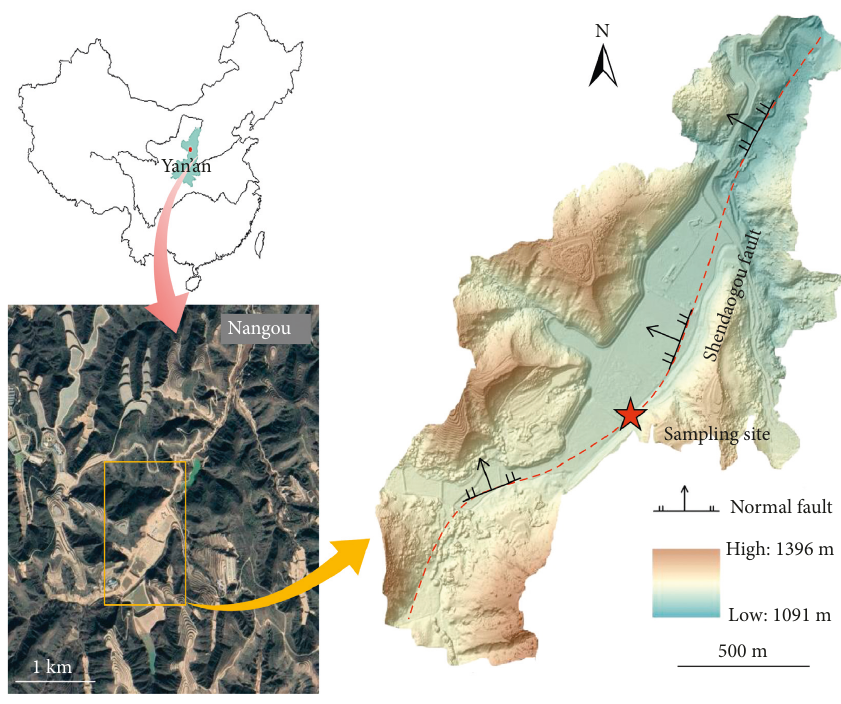
Figure 1: Study area and fault distribution.